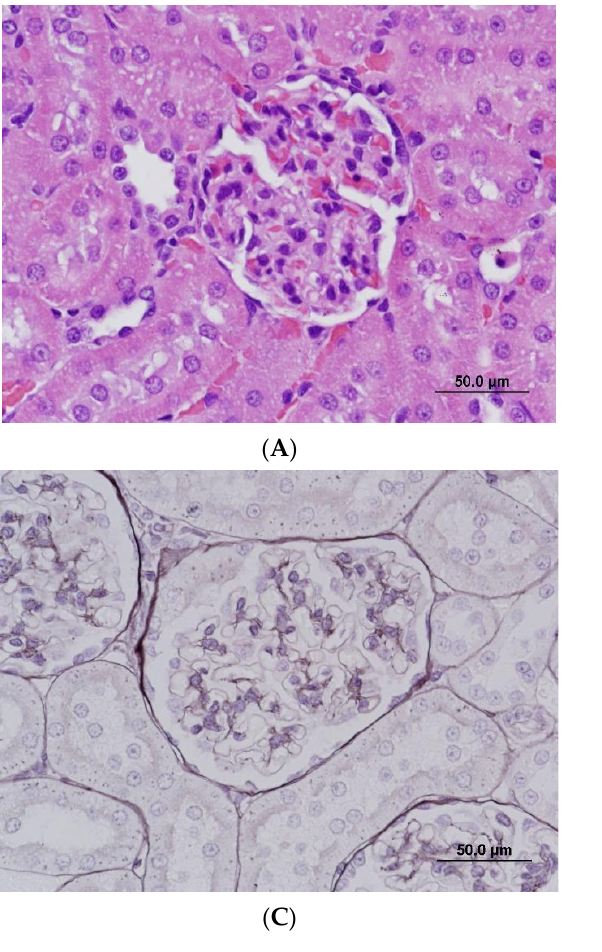
Figure 3. Light microscopy of glomeruli in rats treated with vehicle control ( A , C ) and ABT-123 at 10 mg/kg/day ( B , D ) for seven days. No significant light microscopic changes are apparent on hematoxylin and eosin ( A , B ) and Gomori methenamine silver ( C , D ) preparations. Scale bar = 50 μ m.